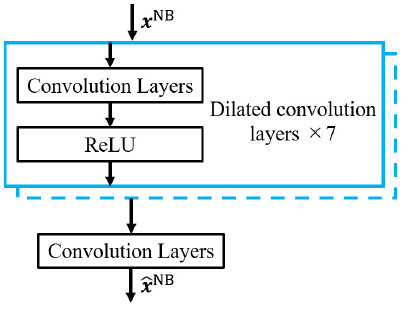
Figure 7. Structure of noise suppression